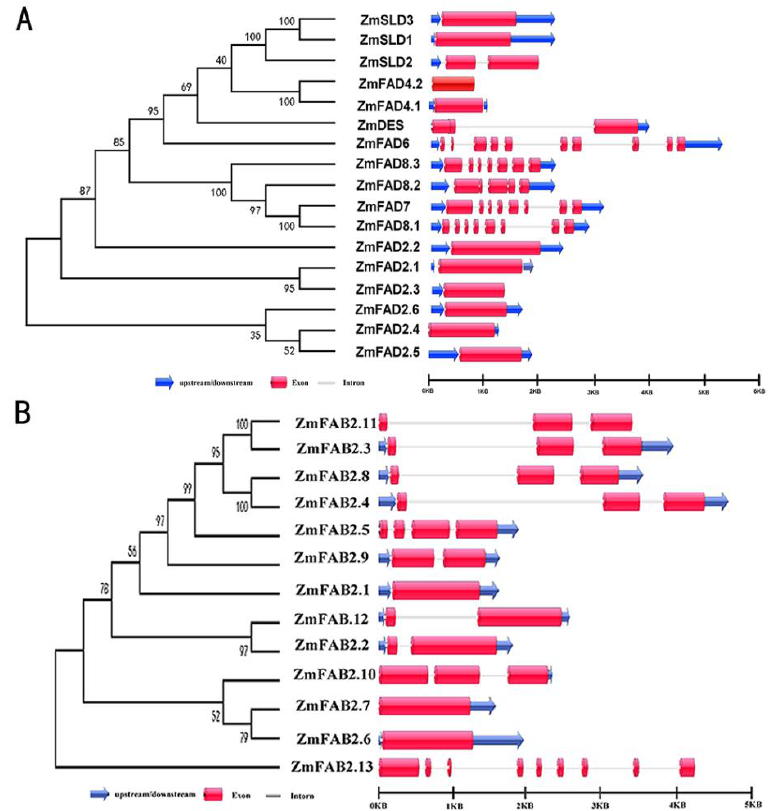
Figure 2. Structure analysis of genes encoding FADs in maize. ( A ) Membrane-bound FADs; ( B ) Soluble FAB2s. The phylogenetic tree is shown on the left, and exon / intron organization is shown on the right. Exons and introns are indicated by red boxes and gray lines, respectively, and untranslated regions are represented by blue arrows.